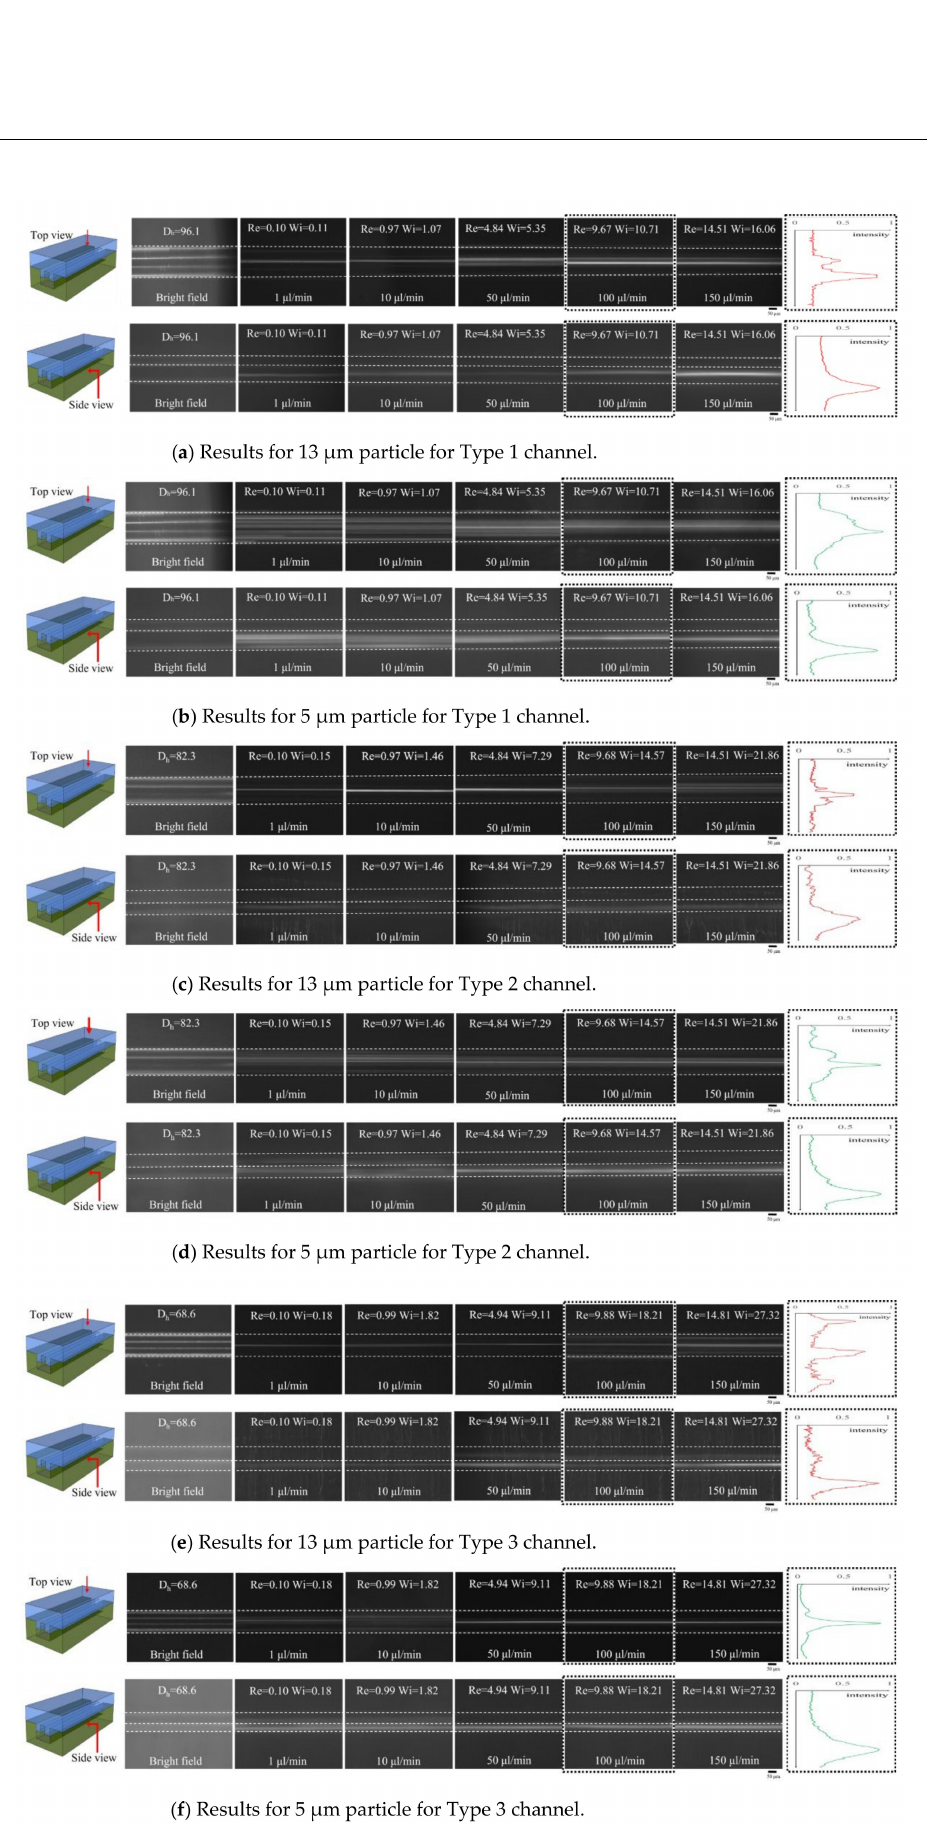
Figure 5. Optical images and intensity graphs (top and side view) of particle focusing under vis- coelastic fluid according to various flow rates for three types of